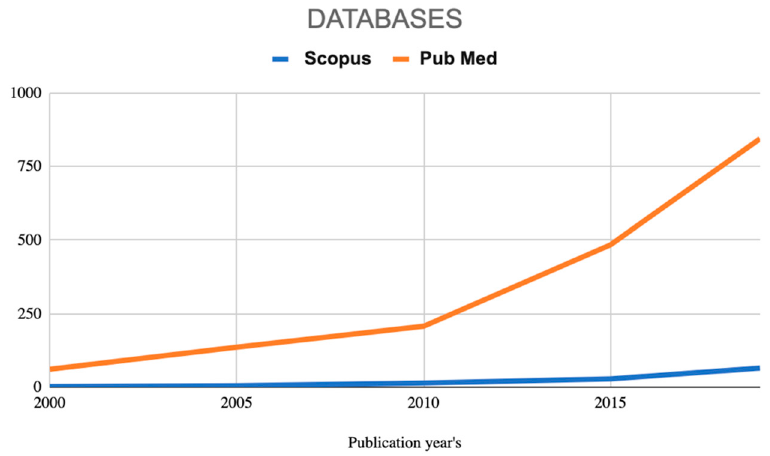
Figure 1. PubMed and Scopus publication trend between 2000 and August 2020.